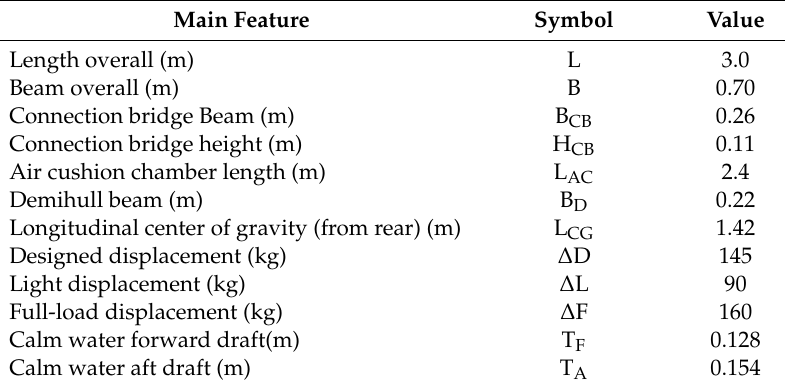
Figure 2. Main dimensions of the hull.